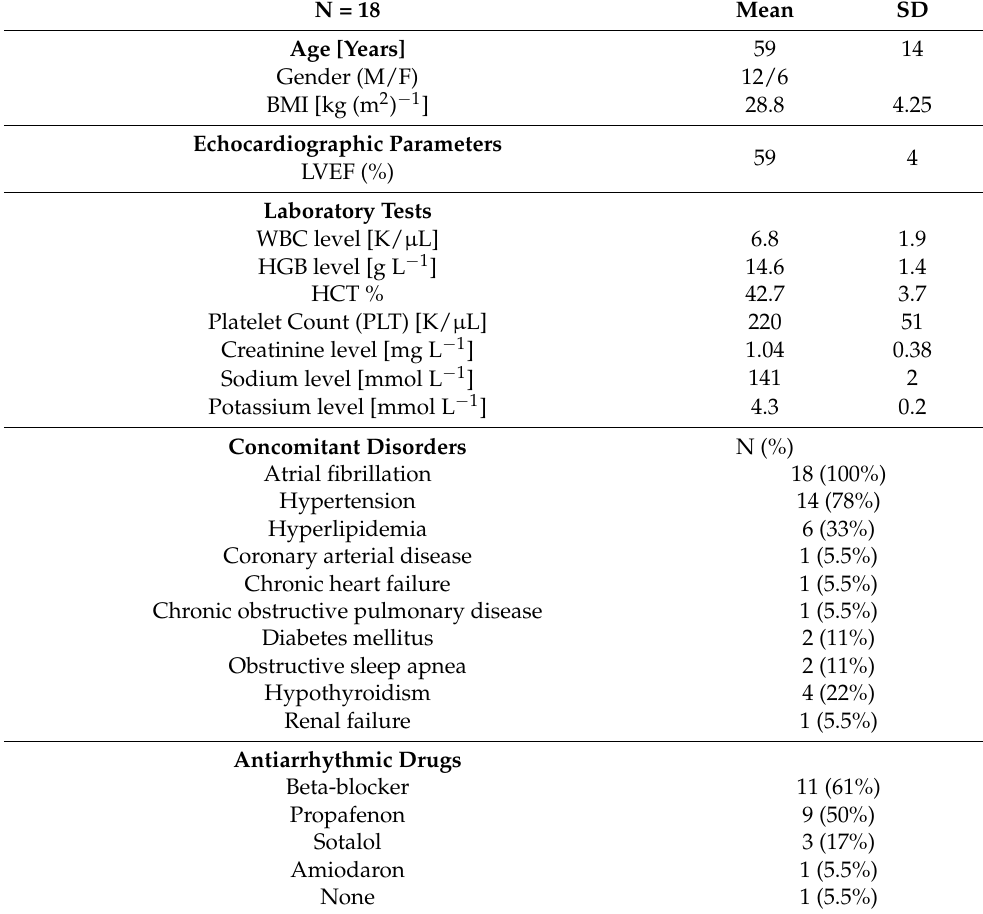
Table 4. Demographic and clinical characteristics of patients participating in the ELEPHANT III